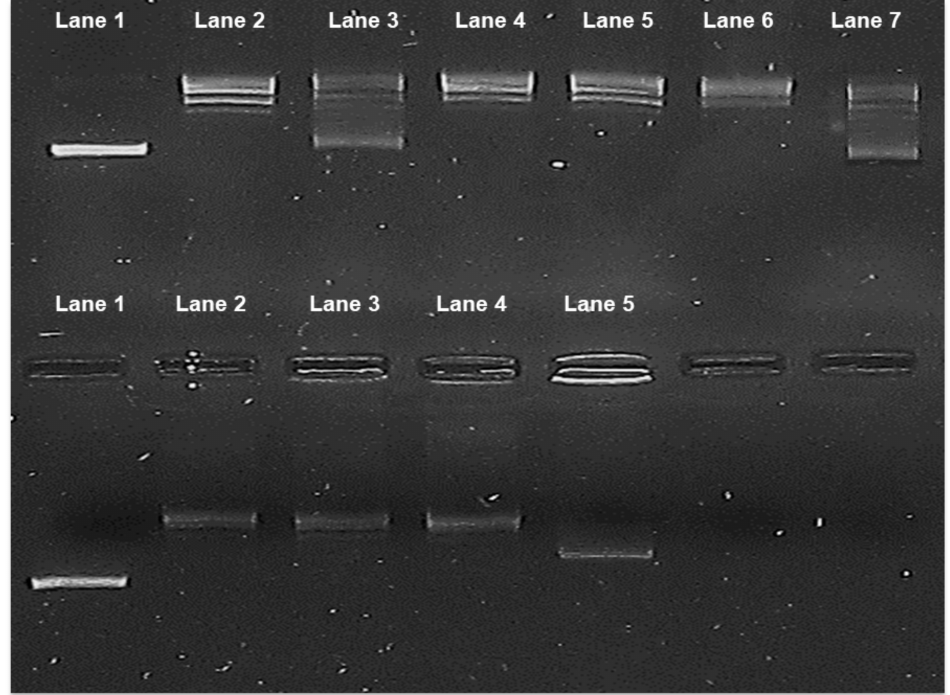
Figure 3. Inhibition of Topoisomerase I activity by single or two-drug combinations treatment. Purified Topo I enzyme from calf thymus was assessed. Upper part : Lane 1, supercoiled untreated plasmid pUC19, Lane 2, plasmid + Topo I (Relaxed form), Lane 3 and 4: treatment with 122.4, 800 µ g/mL and 27 µ g/mL,